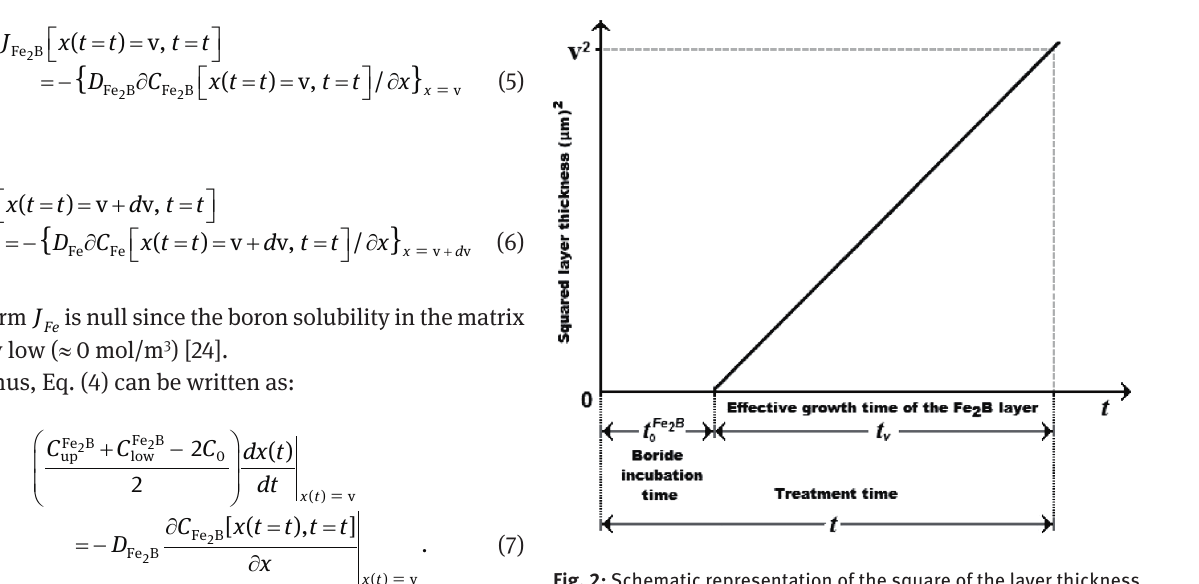
Fig. 2: Schematic representation of the square of the layer thickness against treatment